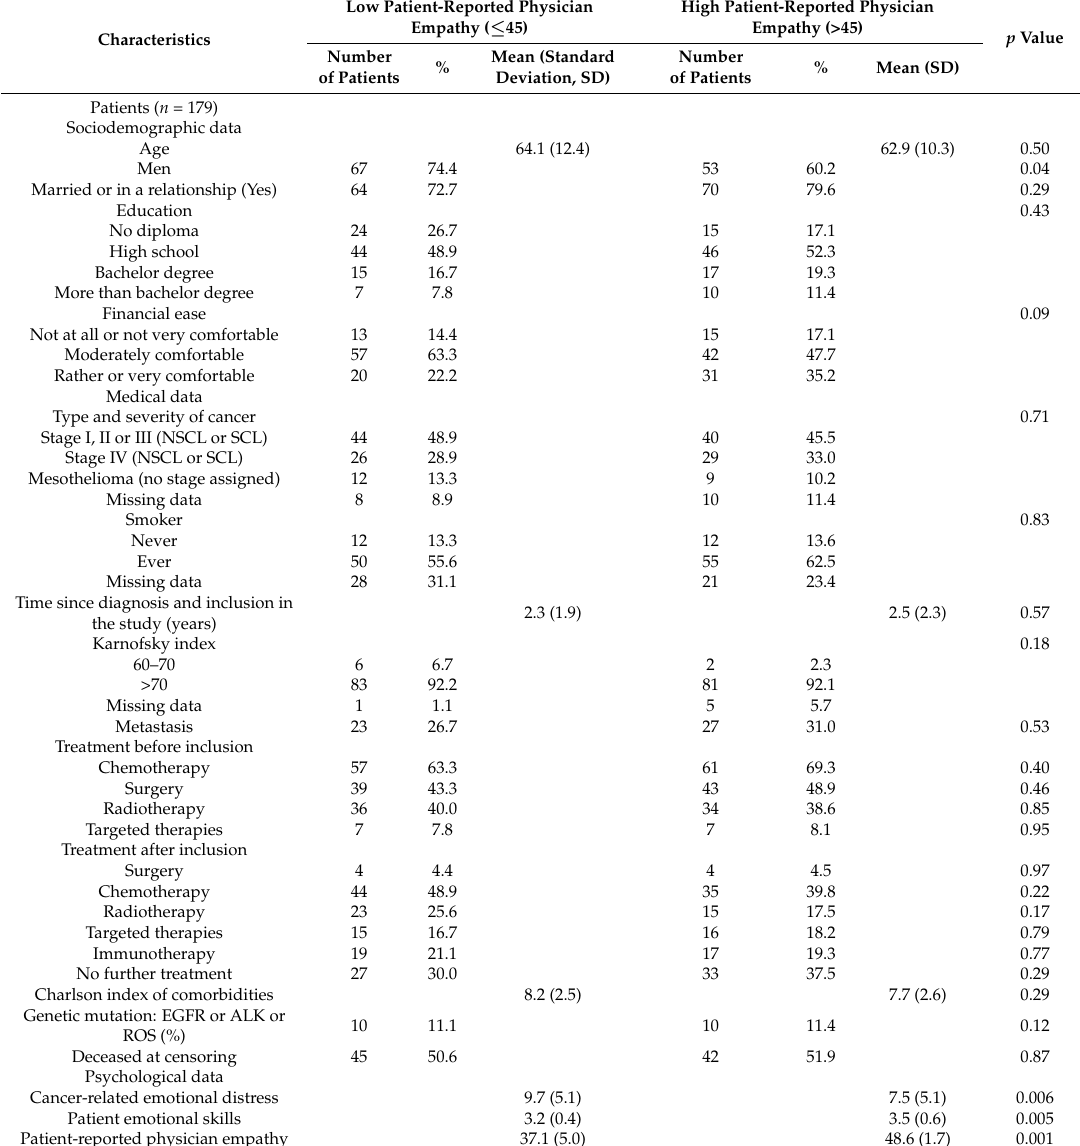
Table A2. Characteristics of patients with low versus high patient-reported physician empathy (median split at